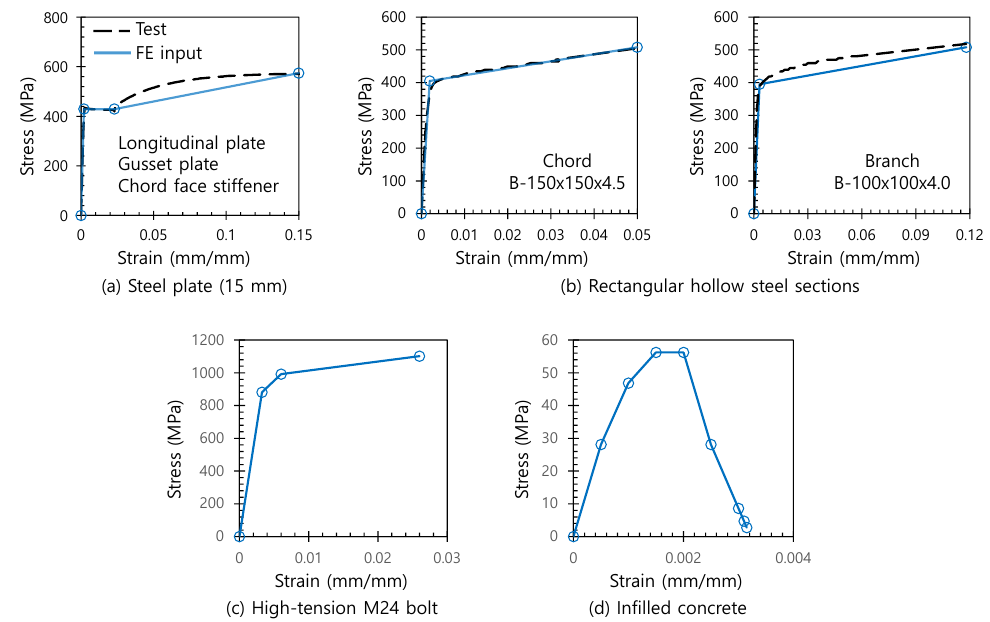
Figure 9. Stress-strain relationships of steel, high-tension bolt, and filled concrete: ( a ) Steel plate (15 mm); ( b ) Rectangular hollow steel sections; ( c ) High-tension M24 bolt; ( d ) Infilled concrete.